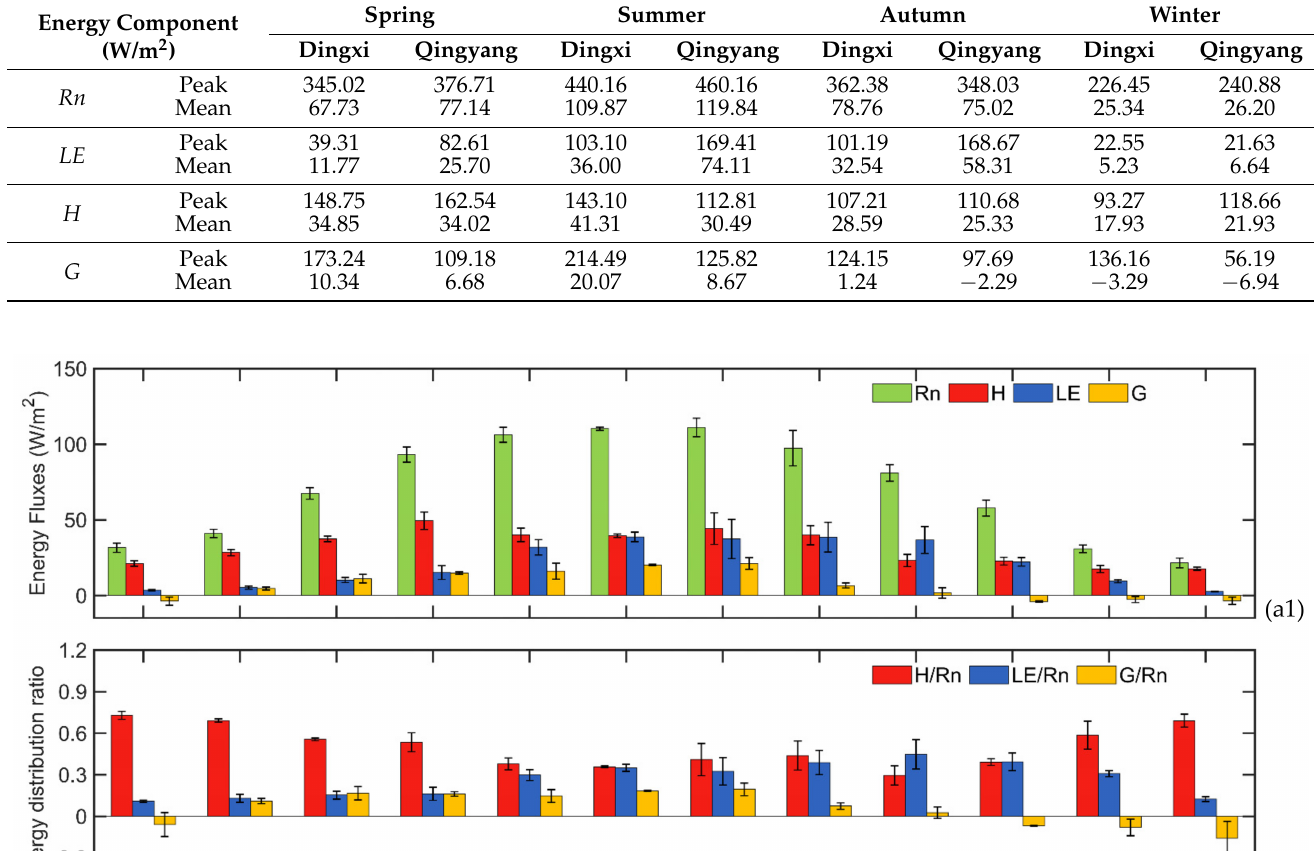
Table 4. Peak and daily average values of the seasonal average daily energy fluxes.